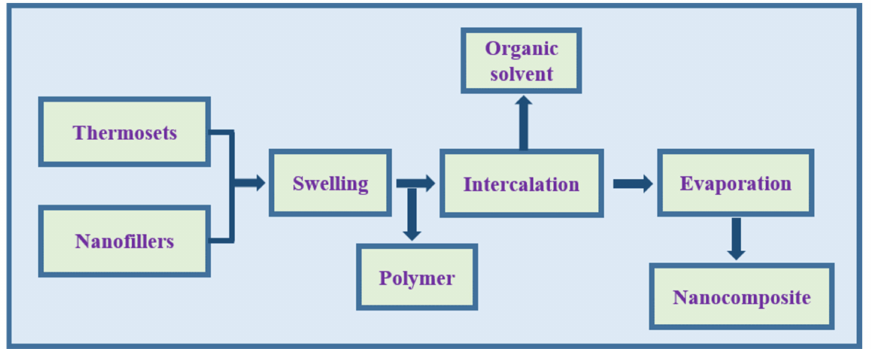
Figure 4. Schematic illustration of solution casting